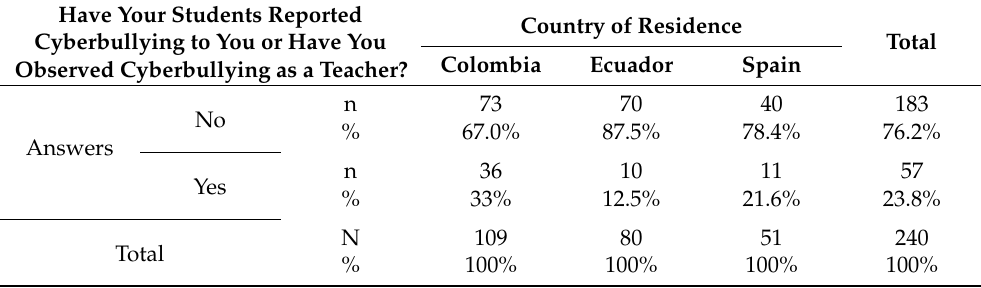
Table 10. Cross-categorization of the variable “Have you observed cyberbullying as a teacher?” and the variable “Country of Residence”.